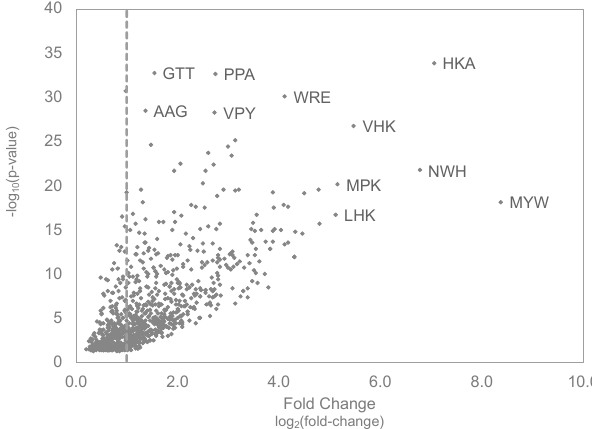
Figure 6. Identification of tumor-selective motifs. MDA-MB-231 breast cancer cell-selective motifs were identified by comparing relative motif frequencies recovered in the tumor compared motifs recovered from the unselected f8/9 phage library. Here, the tissue-specific fold change was plotted against the p -value obtained from a Fisher’s exact test comparing the frequency differences between the two motif populations.